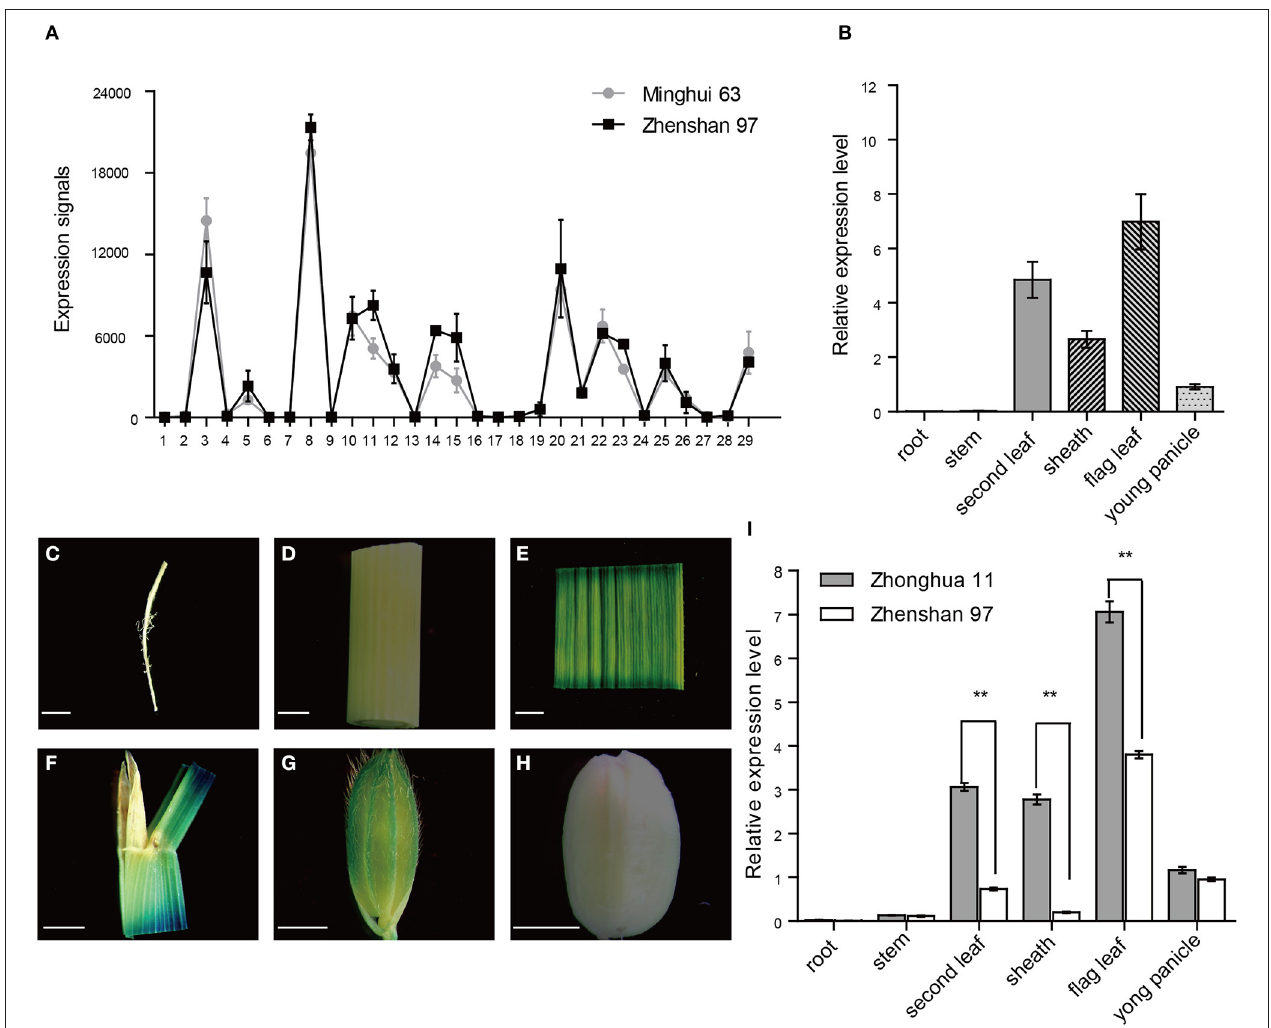
FIGURE 4 | Expression patterns of OsPsbS1 . (A) Expression signals of OsPsbS1 in various tissues of Minghui 63 and Zhenshan 97 based on the microarray data. The X-axis represents the developmental stages which are listed in Table S1. The Y-axis represents the expression signals. (B) Real-time PCR analysis of OsPsbS1 in various tissues of 02428. (C–H) P OsPsbS 1 ::GUS analysis in various tissues of Zhonghua 11. GUS staining shown in primary root (C) , developing culm (D) , flag leaves (E) , leaf sheath (F) , young glume (G) , and mature seed (H) . Scale bars = 2 mm. (I) Comparison of the expression levels of OsPsbS1 between Zhonghua 11 and Zhenshan 97 with different genotypes in the OsPsbS1 promoter region by Real-time PCR. **The differences in expression levels between Zhonghua 11 and Zhenshan 97 are significant at P <